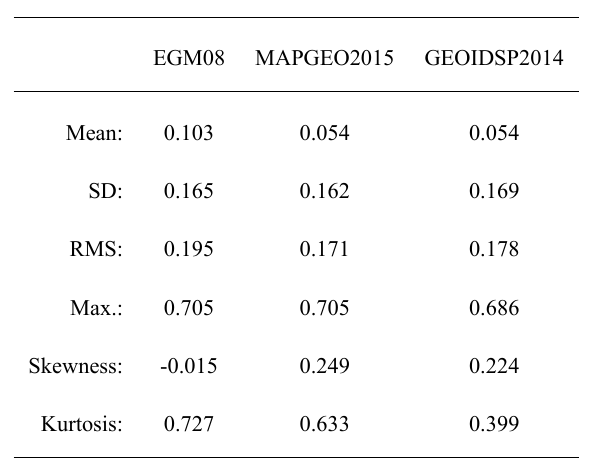
Consistency (in meters) of gravimetric geoids EGM08, MAPGEO2015 and GEOIDSP2014 in relation to tracked leveling points after the first step of filtering